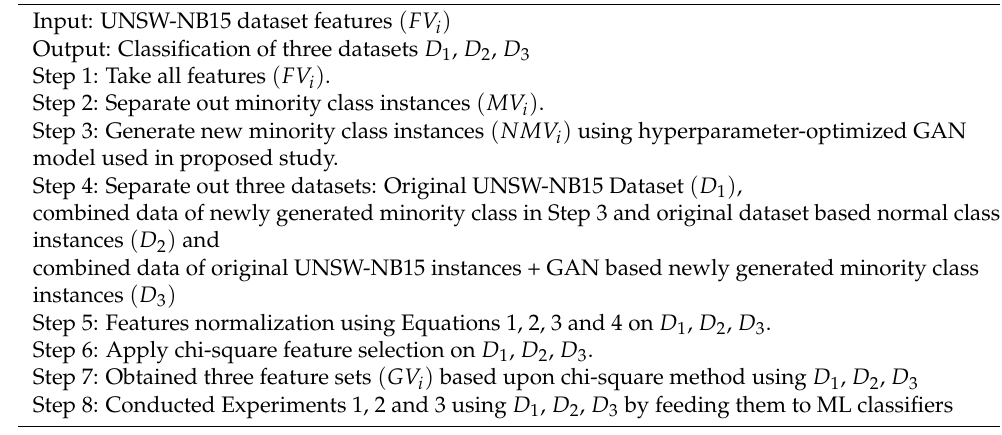
Algorithm 1 Proposed-framework-based algorithm from features input to